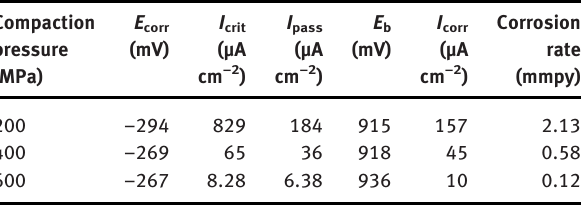
Table 4: Effect of compaction pressure on the electrochemical behaviour of 316L compacts sintered at 1,400°C.